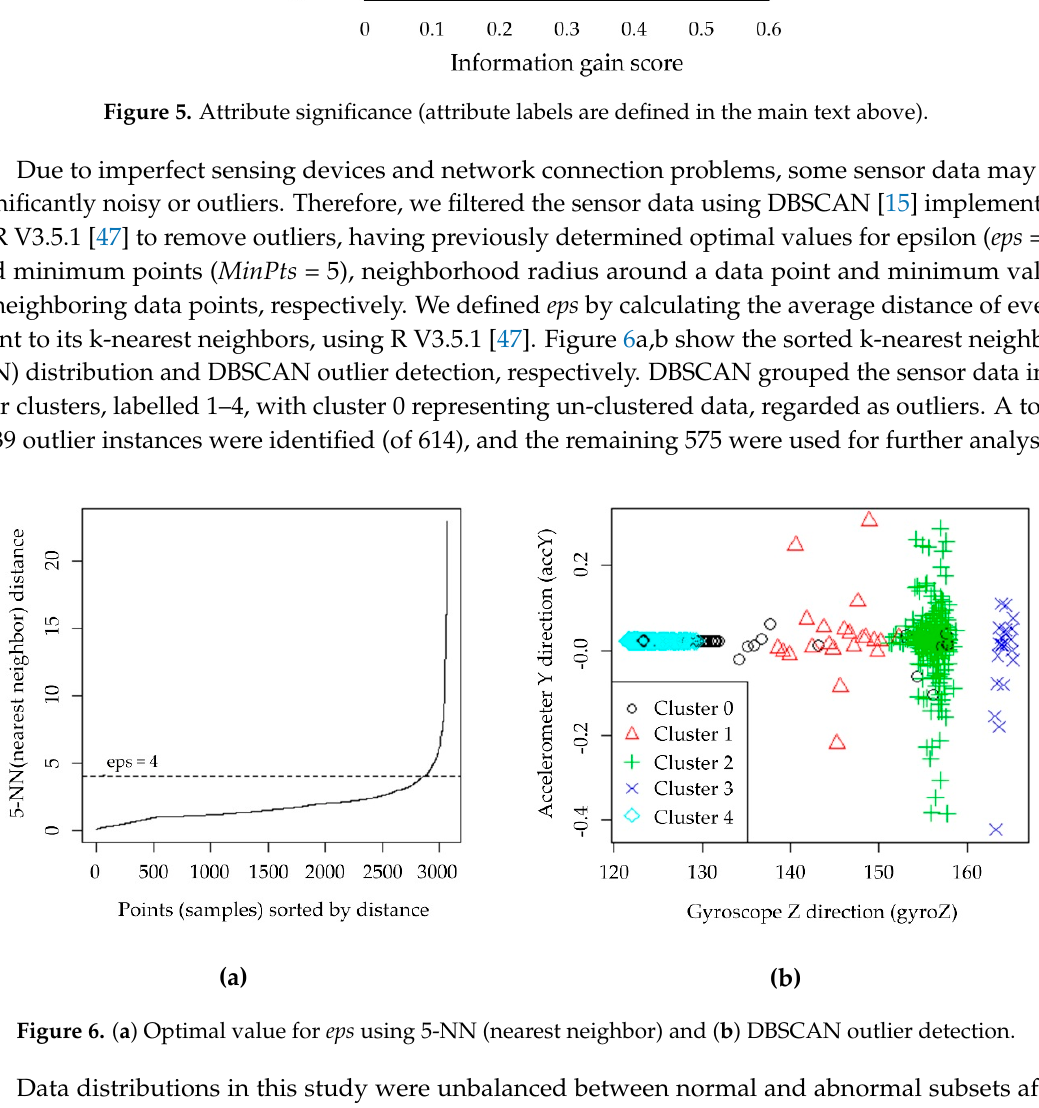
Figure 5. Attribute significance (attribute labels are defined in the main text above).